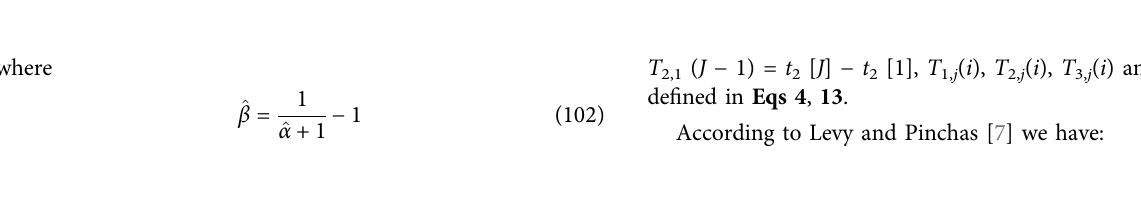
) , H = 0.7, d σ 2 (cid:2) 1 . 44 e − 8 [ sec 2 ] , ω 1 ms = 5 ms , d sm = 5.5 ms , sec < 0 . 3427). The results were obtained for 100 Monte-Carlo fGn / gfGn